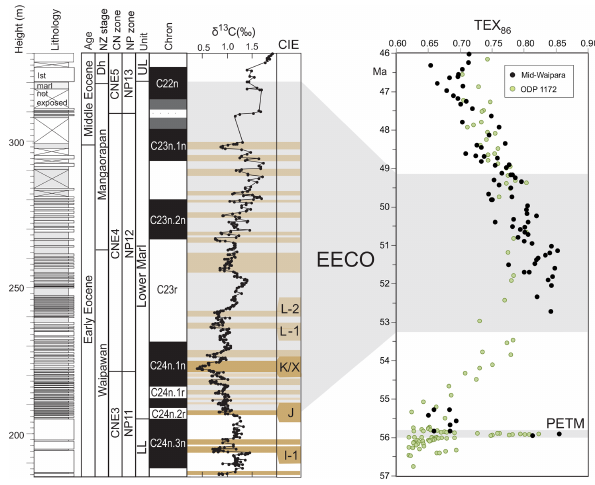
Figure 3. Eocene carbon isotopes and lithostratigraphy at Mead Stream, New Zealand (Slotnick et al., 2012), compared with indica- tors of relative changes in sea surface temperatures: TEX 86 for ODP Site 1172 (Bijl et al., 2009) and mid-Waipara (Hollis et al., 2012; Crouch et al., 2019.). Grey shading = EECO interval as defined by Westerhold et al.